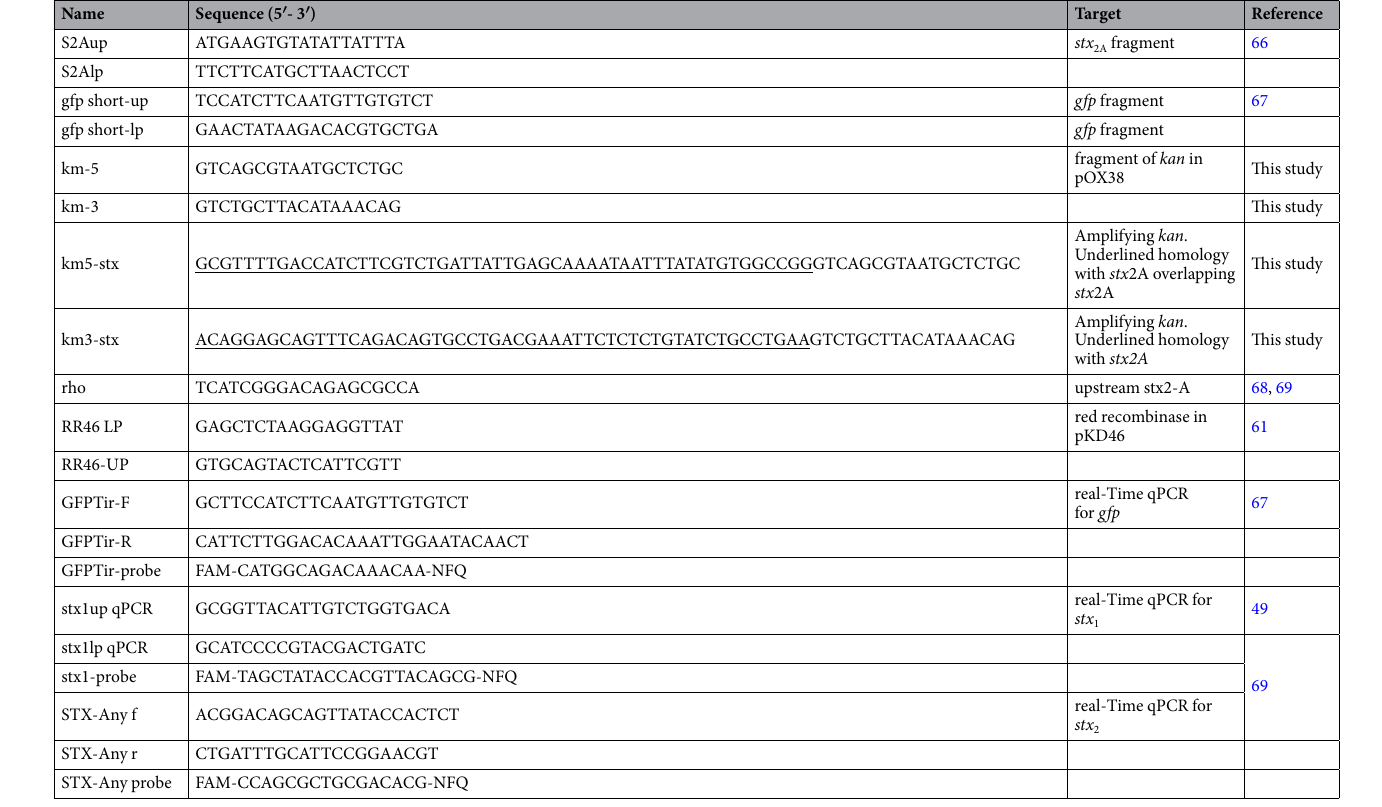
Table 2. Oligonucleotides used in this